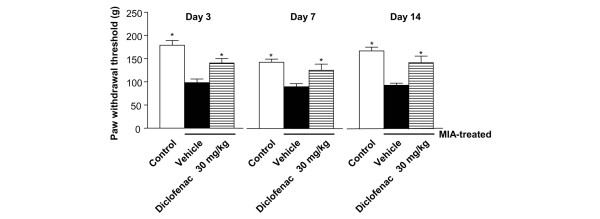
Effect of diclofenac on mechanical hyperalgesia after monosodium iodoacetate (MIA) injection. Effect of diclofenac on paw withdrawal threshold in the paw pressure test in MIA-treated animals on days 3, 7 and 14 after arthritis induction. Rats were tested 45 to 60 minutes post-drug. Data from 12 animals/group are presented as mean ± SEM. *P < 0.05 Dunnett's test versus MIA/vehicle treated animals.